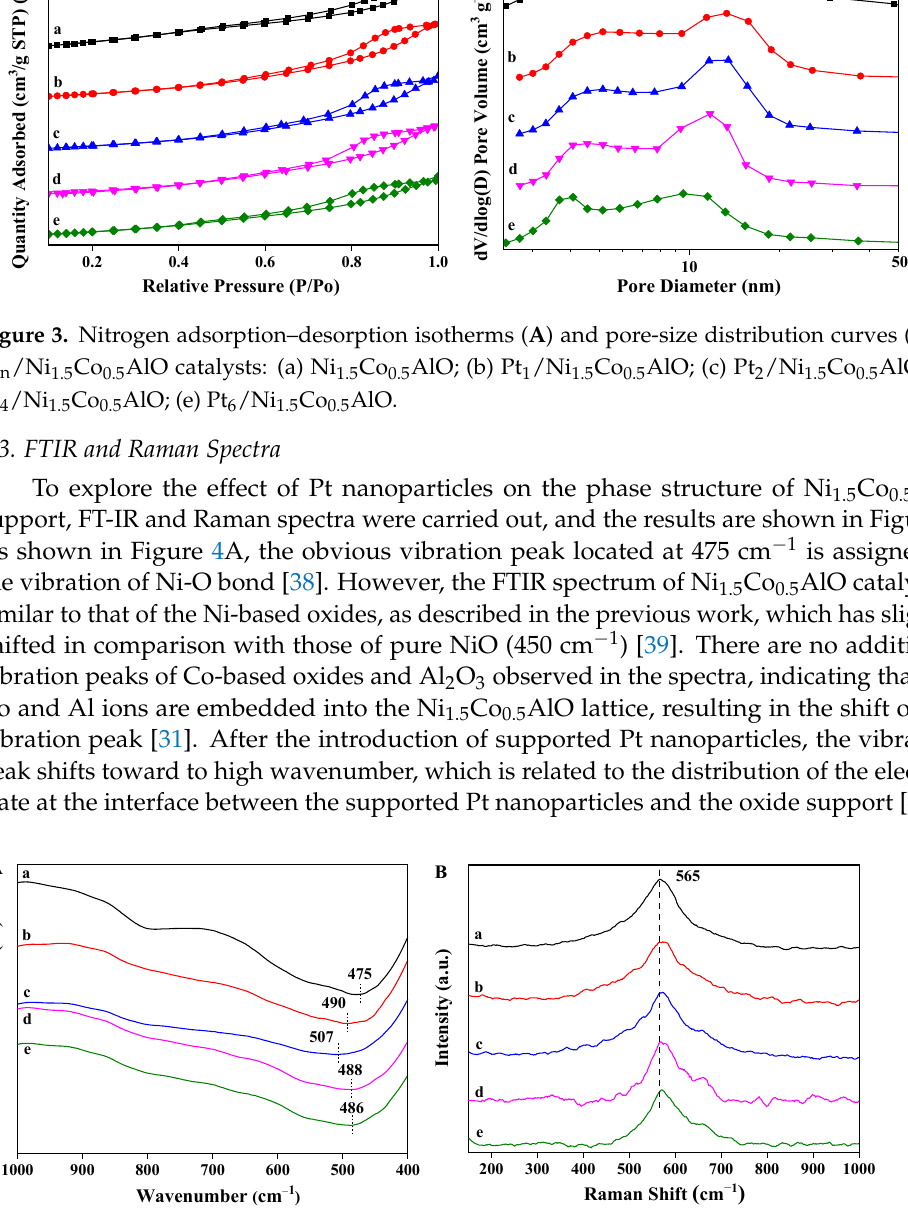
Figure 4. FT-IR spectra ( A ) and Raman spectra ( B ) of Pt n /Ni 1.5 Co 0.5 AlO catalysts: (a) Ni 1.5 Co 0.5 AlO; (b) Pt 1 /Ni 1.5 Co 0.5 AlO; (c) Pt 2 /Ni 1.5 Co 0.5 AlO; (d) Pt 4 /Ni 1.5 Co 0.5 AlO; (e) Pt 6 /Ni 1.5 Co 0.5 AlO.